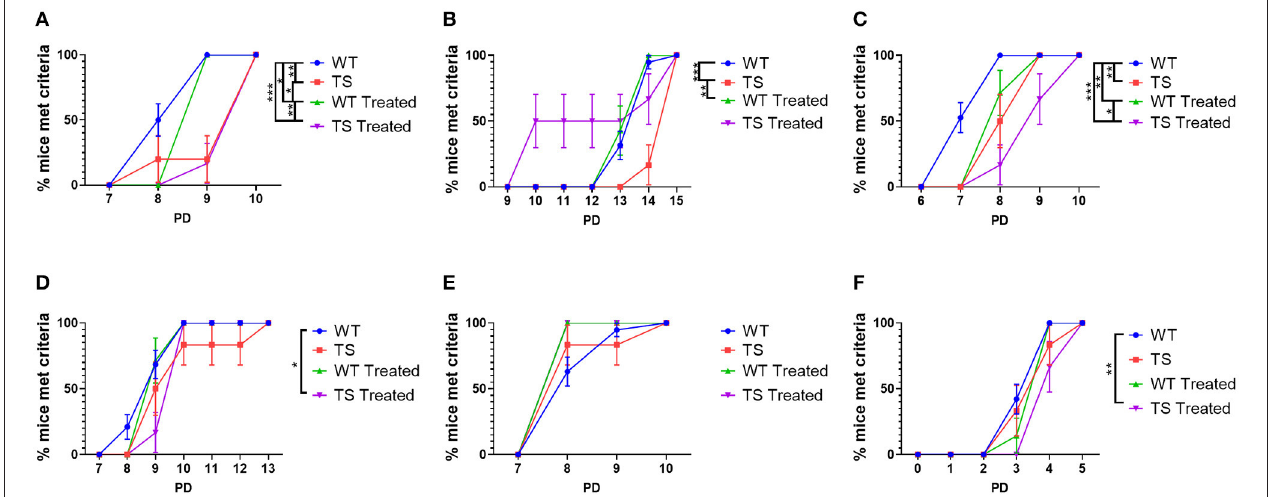
FIGURE 6 | Acquisition of developmental neurobehavioral traits in wild-type and Ts65Dn mice, and effects of GTE-EGCG treatment. (A) Incisor eruption, (B) eye opening, (C) tactile orientation, (D) vibrissae placing, (E) blast response and (F) pinna detachment are represented as a cumulative incidence graph at each postnatal days (PD). Data are presented as percentage of mice that achieved the milestones ± standard error of the mean. Sample size: WT = 19 (16 incisor eruption), TS = 6 (5 incisor eruption), WT Treated = 7, TS Treated = 6. Statistical significance, evaluated using a logrank test, is indicated as * p < 0.05; ** p < 0.01; *** p < 0.001.